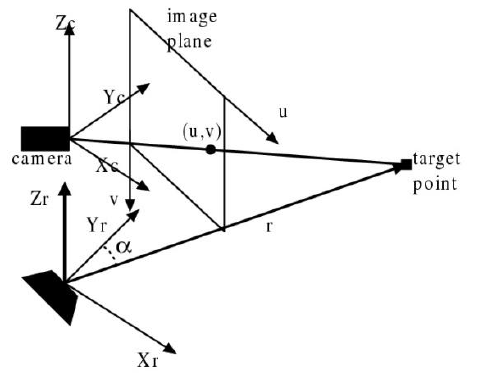
Figure 2. Sketch of the target point in the radar and camera coordinate systems